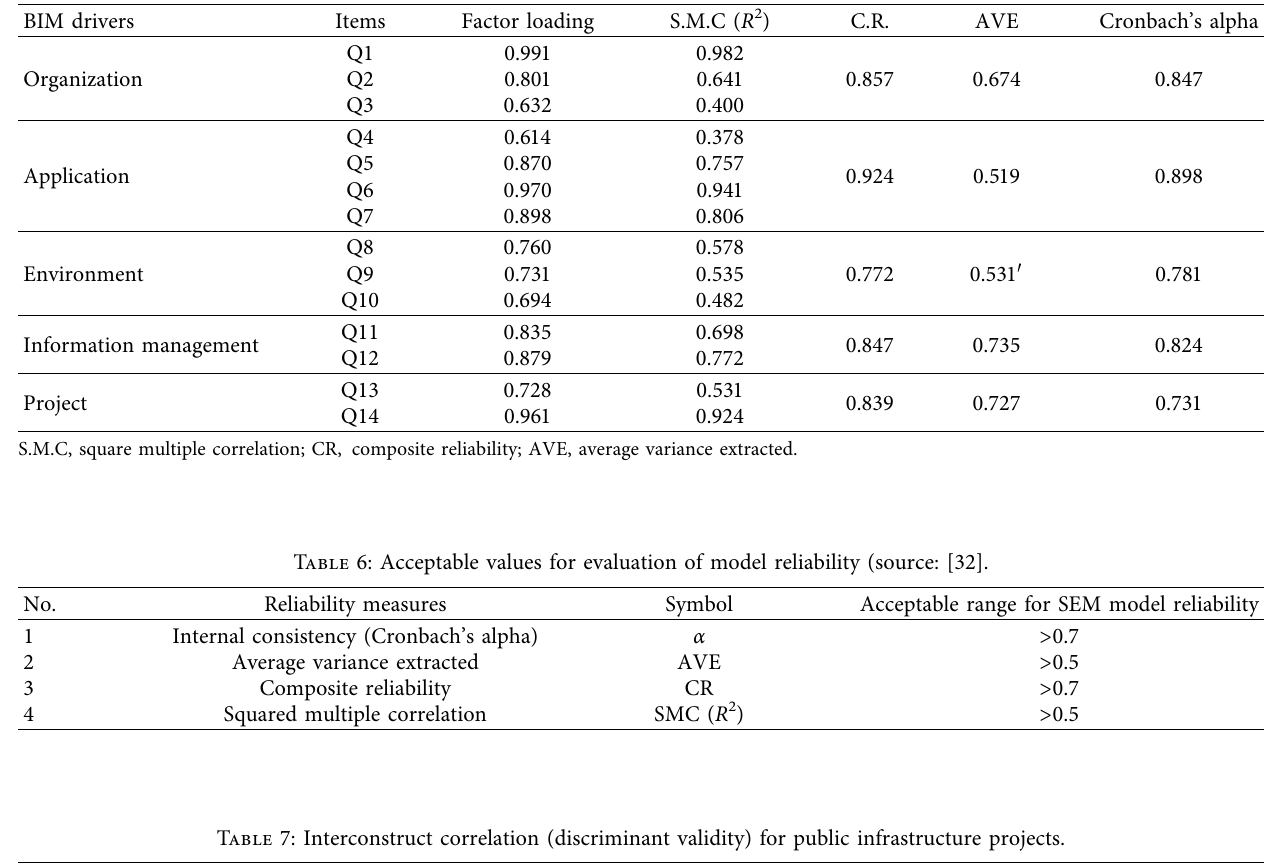
Table 5: Measurement model analysis summary for public infrastructure